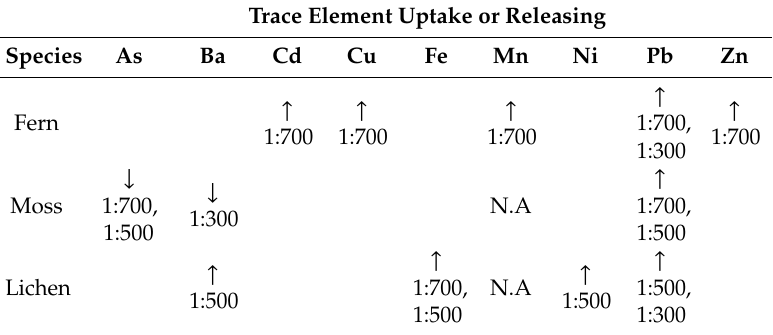
Table 2. Variations of trace elements content ( ↑ uptake, ↓ release, N.A not analyzed) in di ff erent organisms after the application of wood distillate (at 1:700, 1:500 and 1:300). Cumulative summary based on the data obtained at the end of the experiments – 72 h of exposure for the fern (this study) and 24 h for moss and lichen